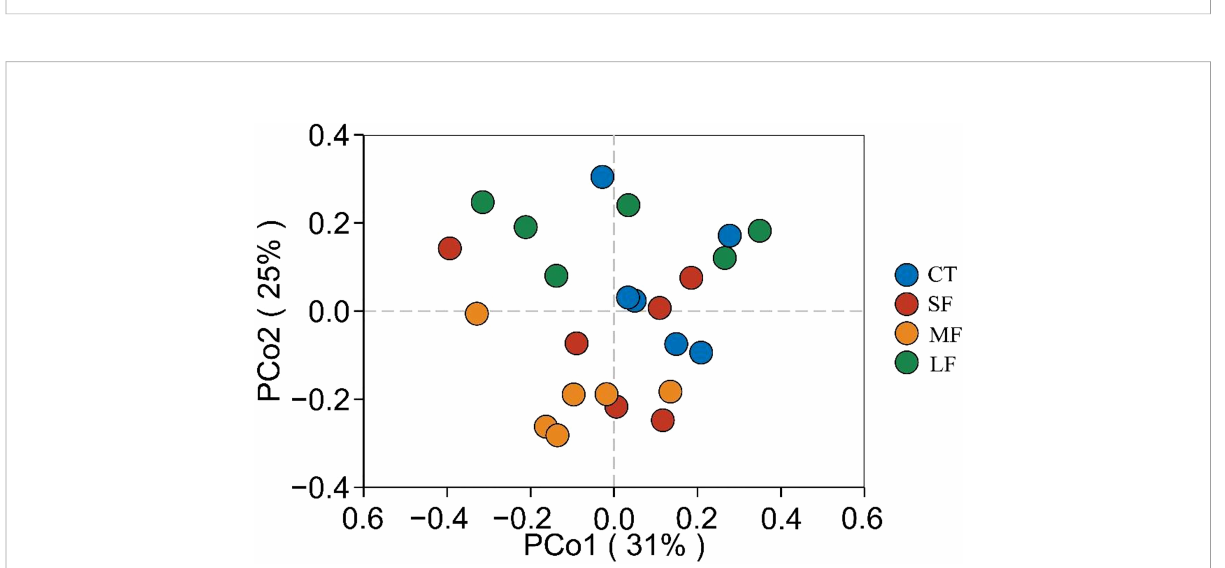
FIGURE 7 Principal coordinate analysis (PCoA) plots of the gut microbial community of juvenile crabs at different levels of DTF (28°C, 28 ± 2°C, 28 ± 4°C, 28 ±